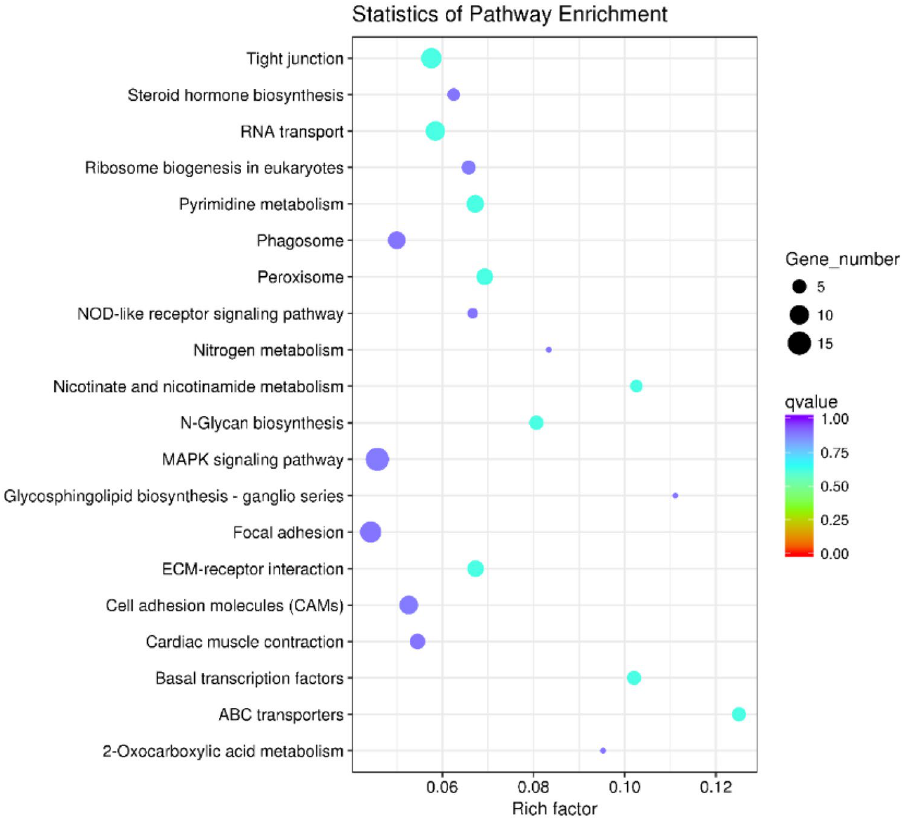
Figure 4. The 20 most enriched KEGG pathways enriched by the putative target genes of the differentially expressed